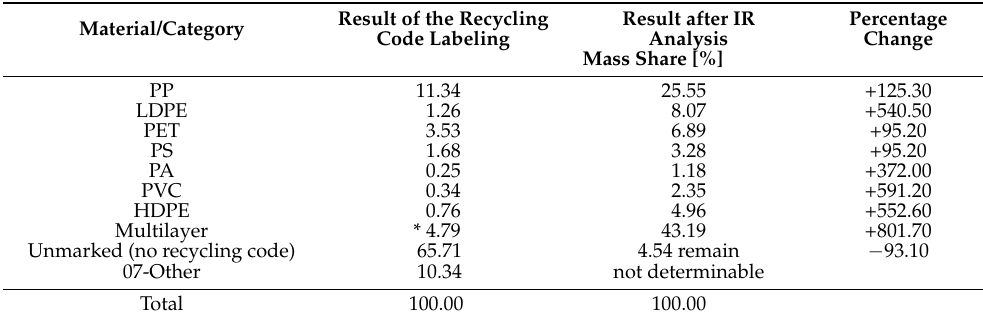
Table 7. Packaging material proportions for the IR sample (1190 items), before and after their identification by IR analysis, based on